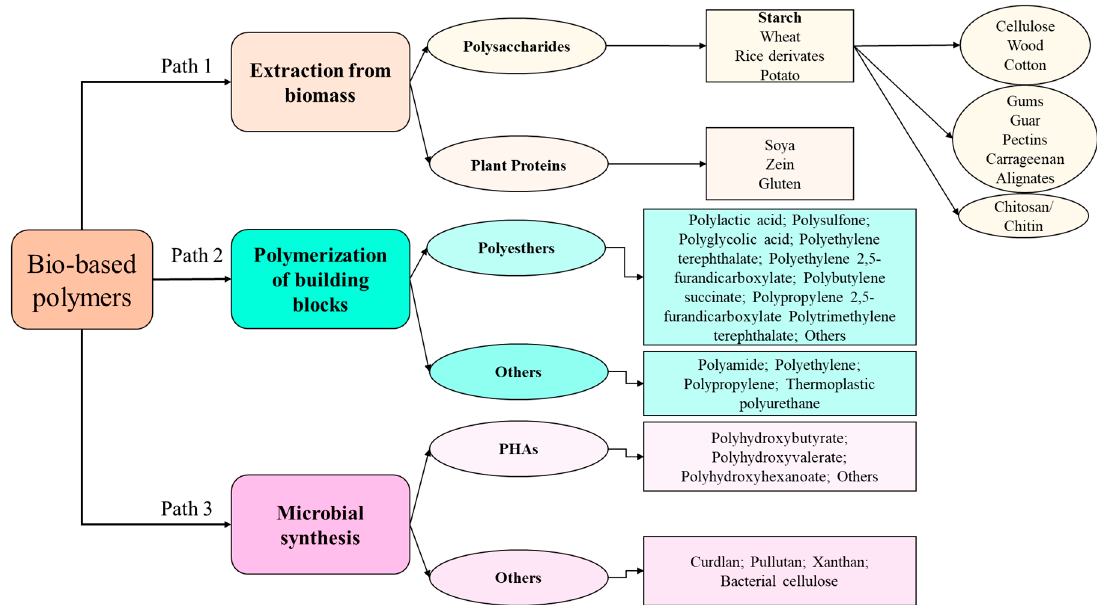
Figure 3. Bio-based polymers obtaining routes: (1) extraction from biomass; (2) polymerization of bio-based building blocks, and (3) microbial